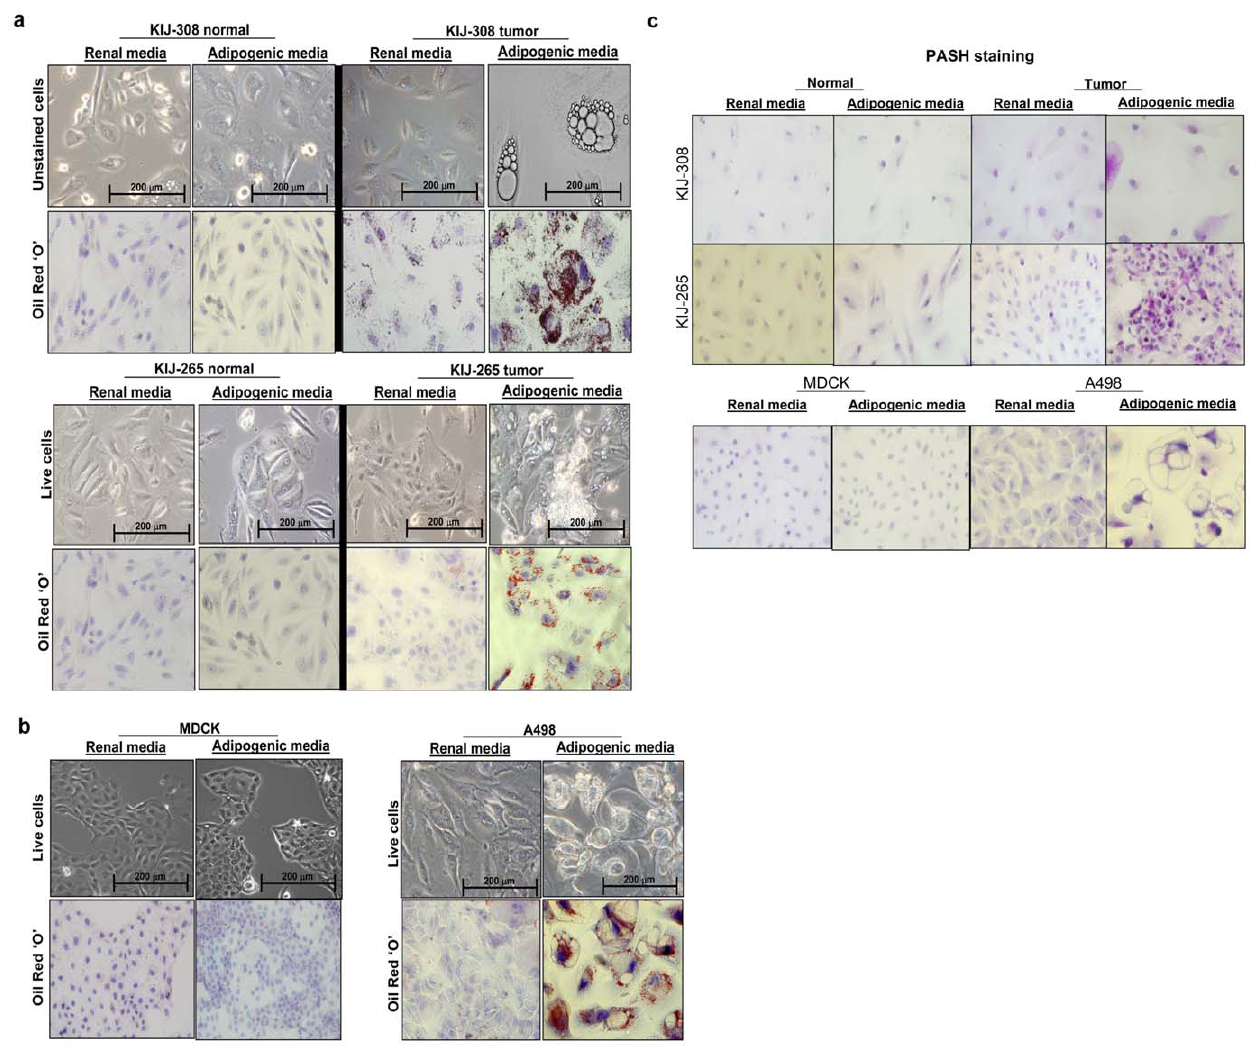
Figure 5. Adipogenic differentation in clear cell renal cell carcinoma. a. Cellular differentiation experiments showing that KIJ-308 and KIJ- 265 ccRCC cells are capable of adipogenic differentiation and become lipid-laden in adipogenic media, as indicated by Oil Red ‘O’ staining. Normal patient-matched cells were unable to differentiate. b. A498 ccRCC cells are also capable of adipogenic differentiation, as indicated by Oil Red ‘O’ staining, unlike normal renal canine MDCK cells. c. Under adipogenic media conditions, ccRCC also produces glycogen, as shown by a PASH